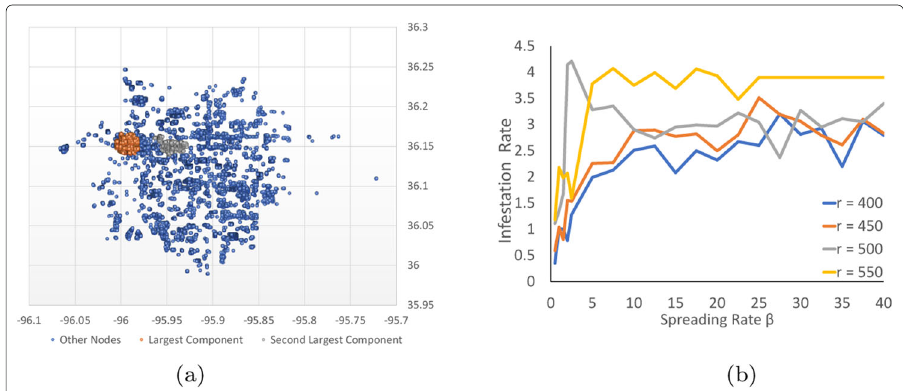
Fig. 3 Citywide Network and Infestation Percentage for Tulsa. a Tulsa map with LCC shown in orange for r = 450. b Tulsa citywide infestation percentage with varying migration radius r